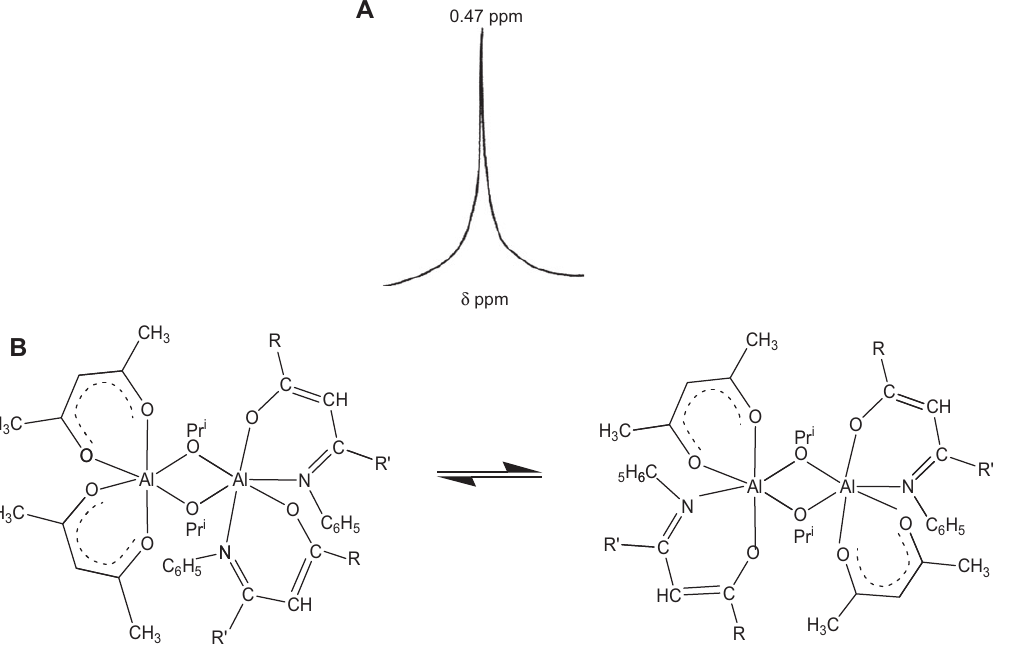
Figure 2 (A) 27 Al NMR spectrum of [6] at room temperature and (B) proposed equilibrium between different species in solution of [(CH COCHCOCH 3